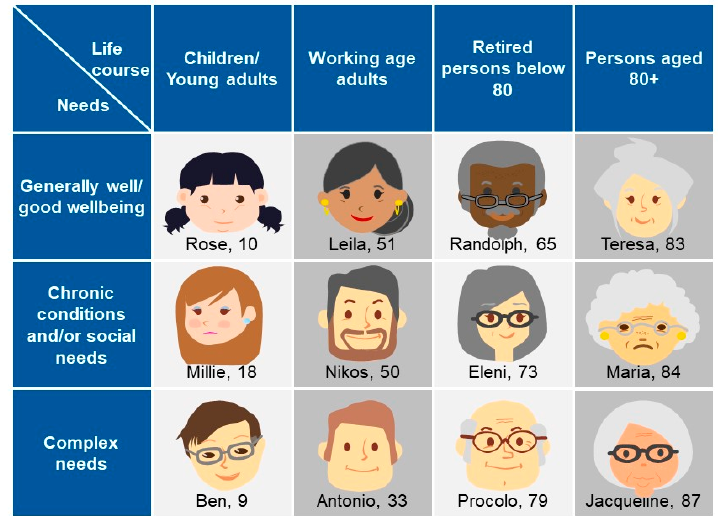
Figure 1. The Blueprint personas developed by Blueprint Partners, representing different needs, aspirations, attitudes, dreams, disease-related characteristics, care needs of certain groups in the society, and identification of what is important to them [68].